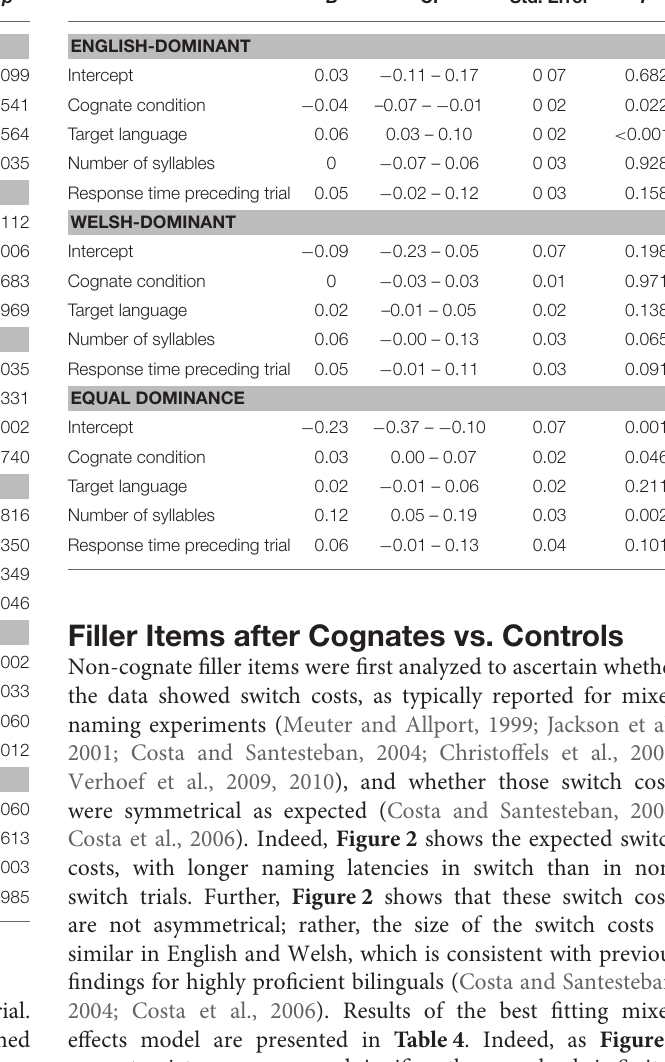
TABLE 3 | Results of the best-fitting linear mixed effects model predicting TABLE 2 | Results of the best-fitting linear mixed effects model predicting log response times for Cognates vs. Controls, for each language log response times for Cognates vs. Controls, for each language dominance group dominance group and each Target Language separately. B CI Std. Error